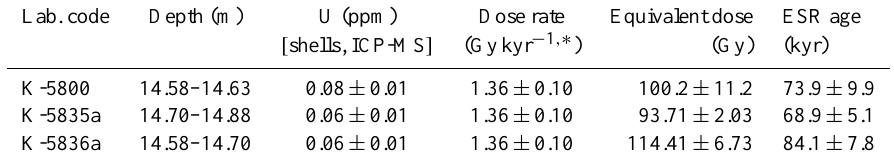
Table 3. Parameters for dose rate calculation, total dose rates, equivalent dose values and ESR ages. All errors represent the 1- σ level.